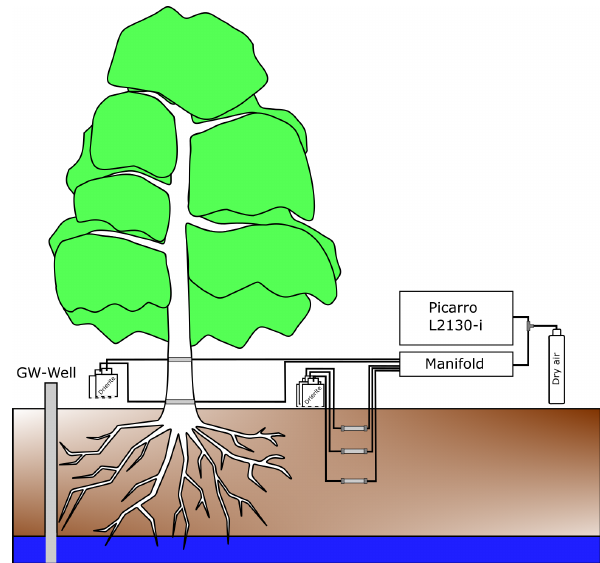
Figure 2. Conceptual graphic of the general in situ isotope measur- ing